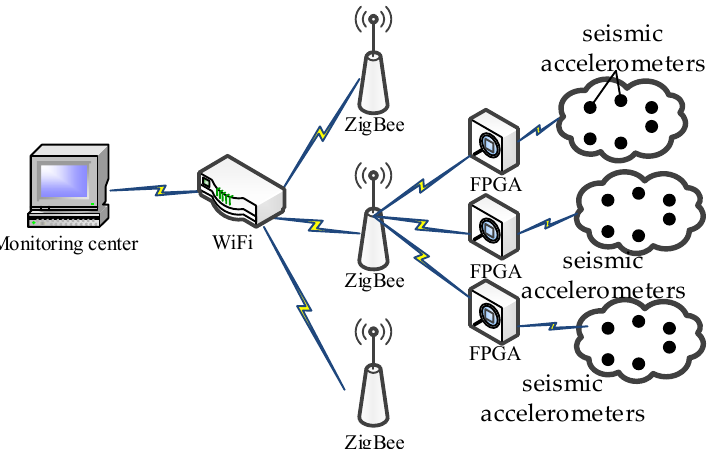
Figure 1. A schematic diagram of seismic data acquisition system, based on wireless transmission. As a key component of seismic data acquisition, the development of seismic accel- erometers directly influences the accuracy of exploration [10].